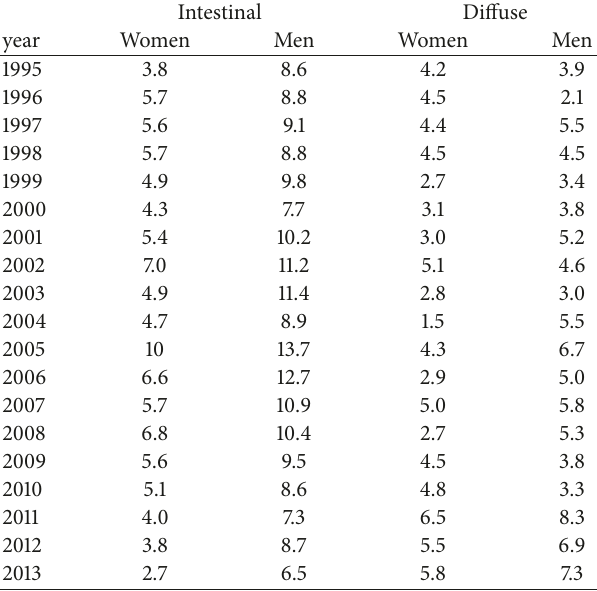
Table 2: Standardized incidence rates for gastric cancer subtype in women and men,